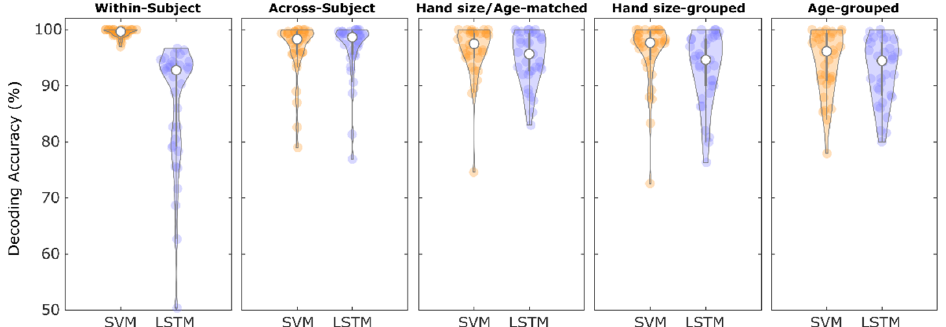
Figure 4. Classifier performance in differently grouped subsets to be left out in the cross-validation (CV). In within-subject CV, SVM performs considerably better than LSTM. Compared to across- subject analysis (leave-one-subject-out CV), both SVM and LSTM classification results are only slightly affected by a smaller amount of training when using two-fold CV (regardless of the grouping characteristics, i.e., matched hand size or age). In addition, grouping participants in two hand size groups and two age groups revealed similar DAs compared to two hand size/age-matched groups using the same amount of training data. Note that the chance level is at 16.6%.